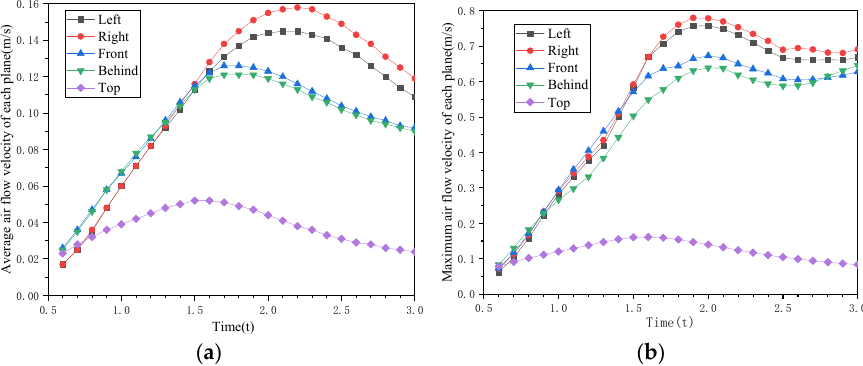
Figure 6. Velocity of air flow field in each plane during unloading process: ( a ) average velocity; ( b ) maximum velocity.